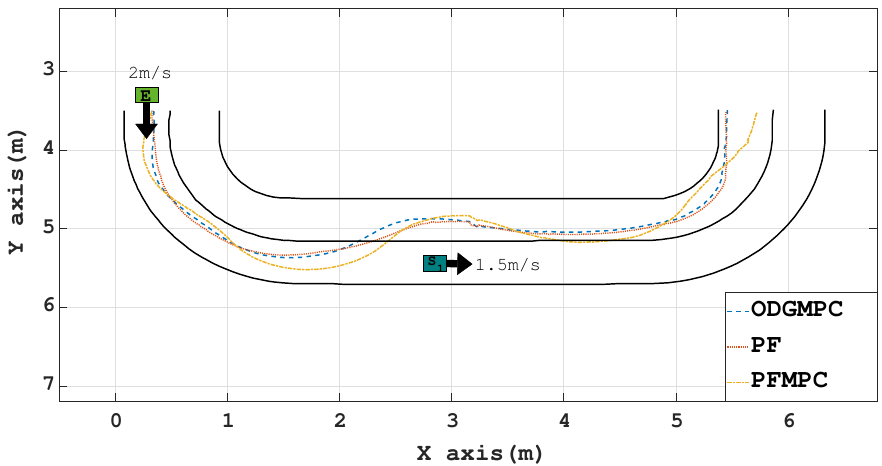
Figure 22. Results of the path from Scenario 2 for a dynamic